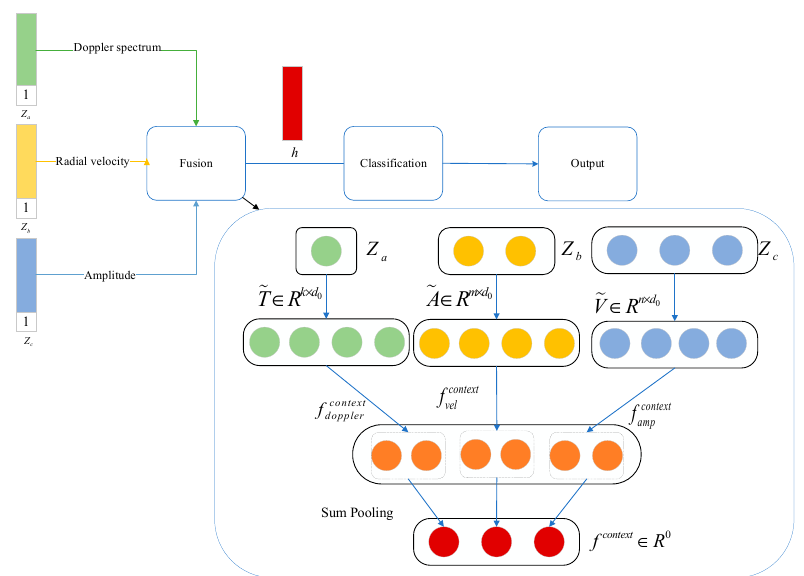
Figure 5. Multimodal low-rank factor normalized representation process.